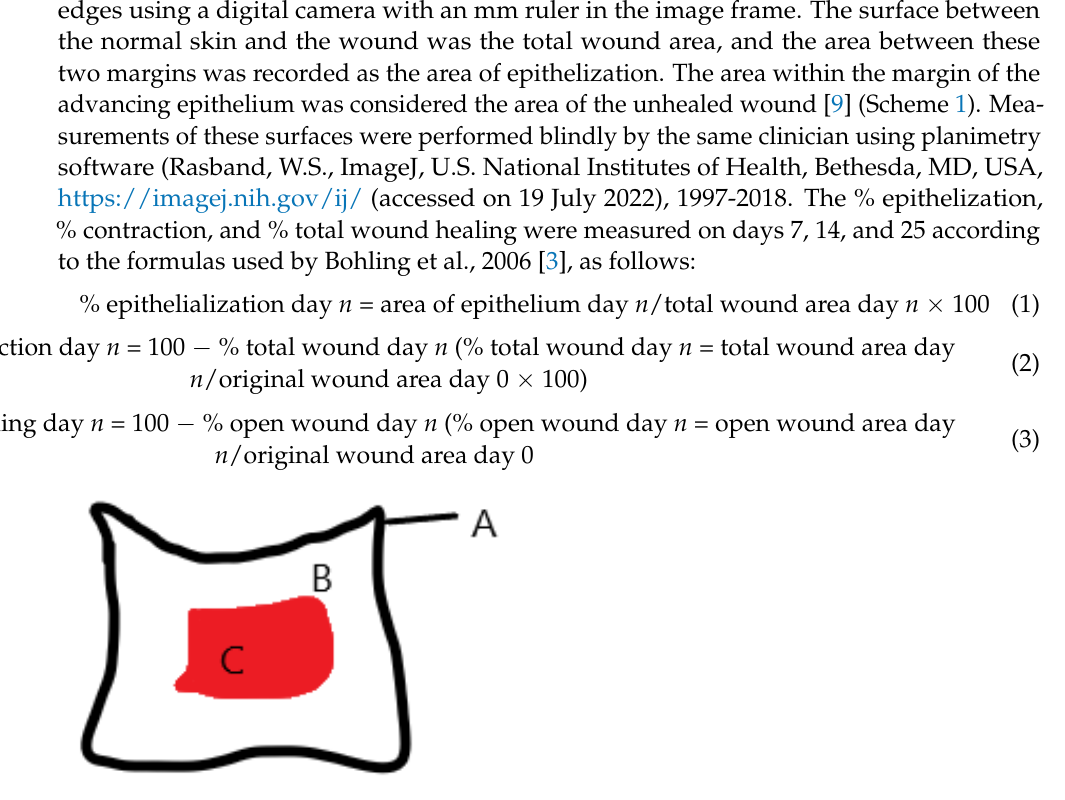
Scheme 1. A: Area between normal skin and epithelium. B: Epithelialization area (B = A − C). C: Open wound (area between epithelium and open